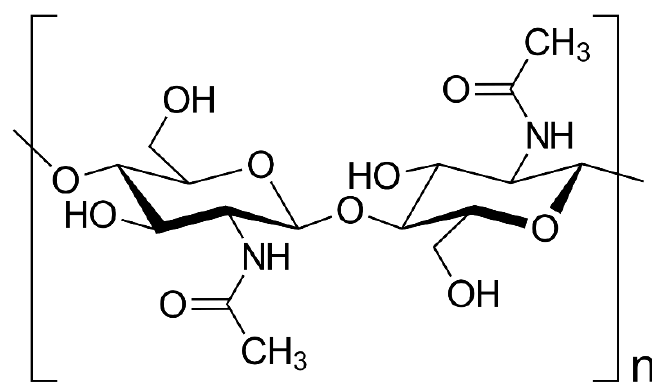
Figure 1. Chemical structure of chitin (Daschnaz 22 August 2007).